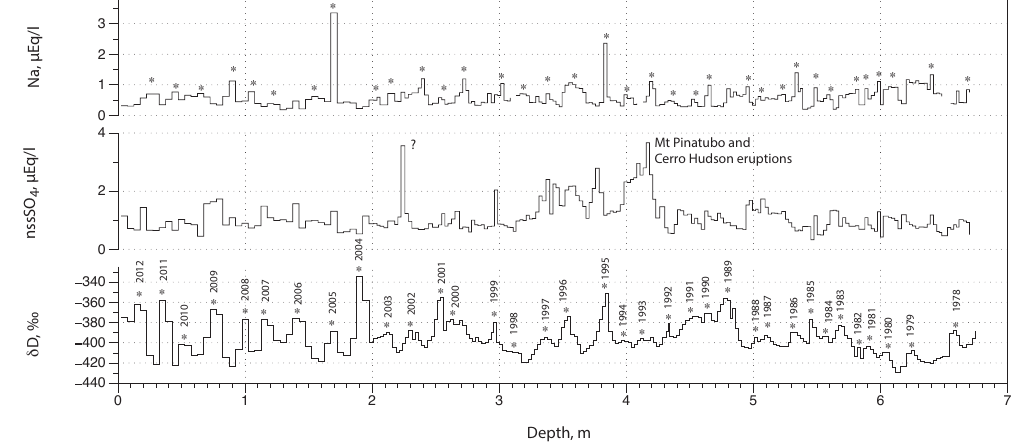
Figure 2. Annual layers identified in the geographic South Pole core obtained in January 2012. Asterisks denote peaks in sodium (Na + ) and deuterium ( δ D), marking mid-winter and mid-summer respectively.